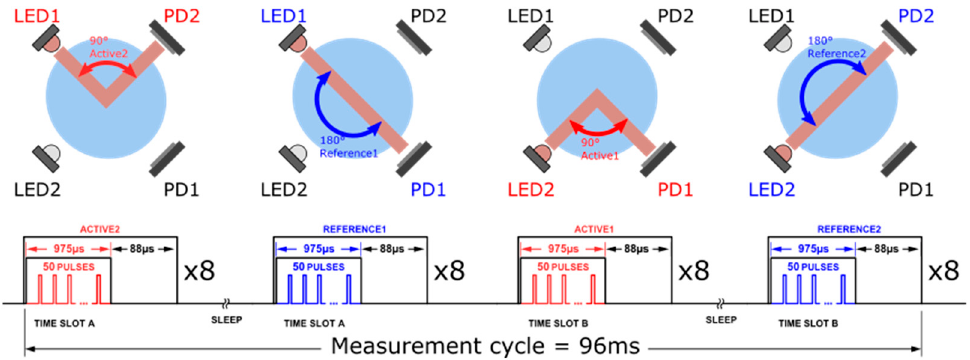
Figure 5. Measurement sequence implemented by the software to measure Active2, Reference1, Active1, and Reference2 signals and corresponding timing diagram illustrating the AFE operation. Each step was performed eight times to perform internal averaging, which allows to improve signal- to-noise ratio. Total measurement time in this configuration is 96 ms.